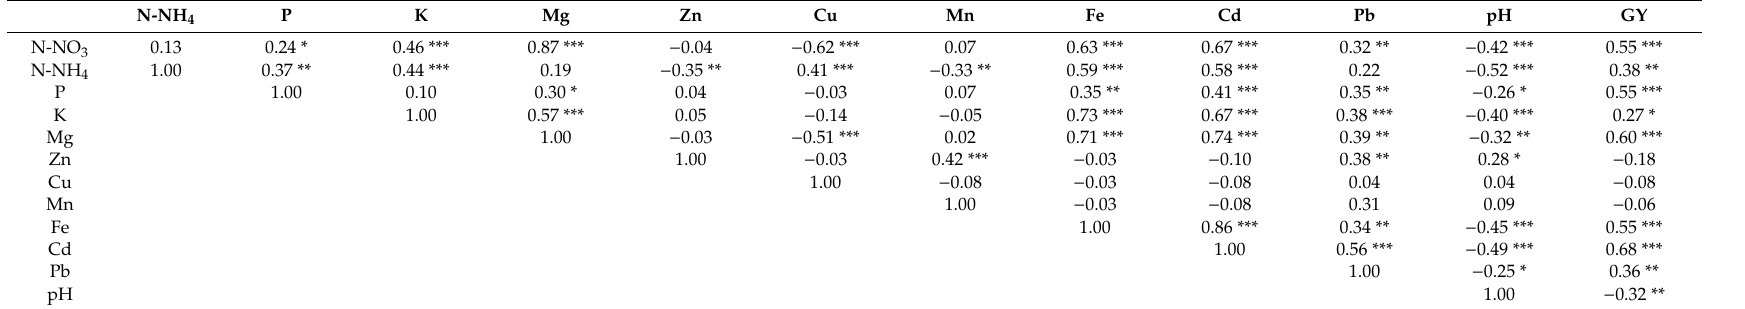
Table A1. Correlation matrix of relationships between the contents of nitrogen and Mehlich3 available elements, n = 72.